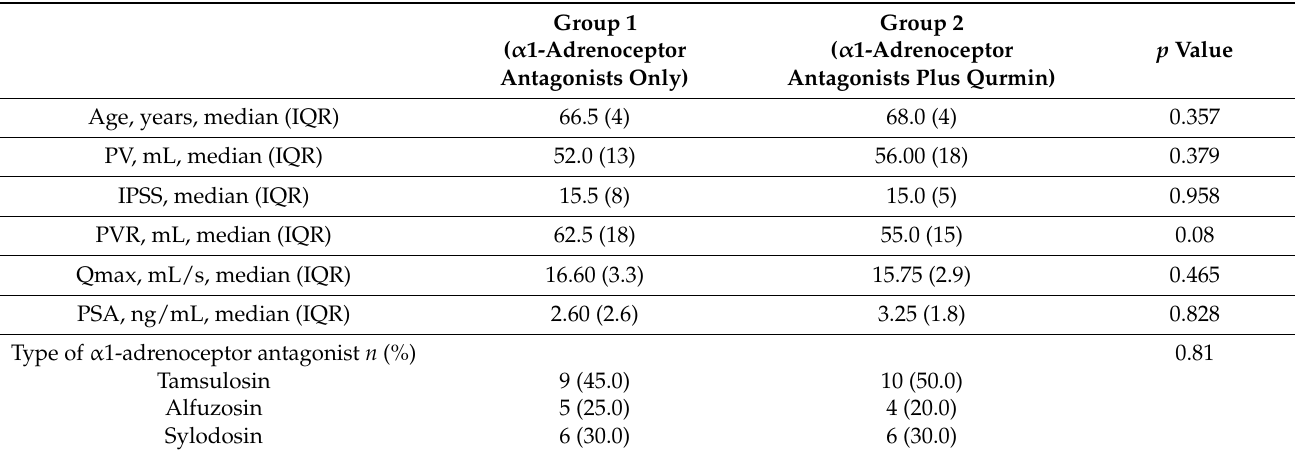
Table 1. Baseline patient characteristics. IQR: interquartile range. PSA: prostate-specific antigen. PV: prostate volume. IPSS: International Prostate Symptom Score. PVR: post-voiding